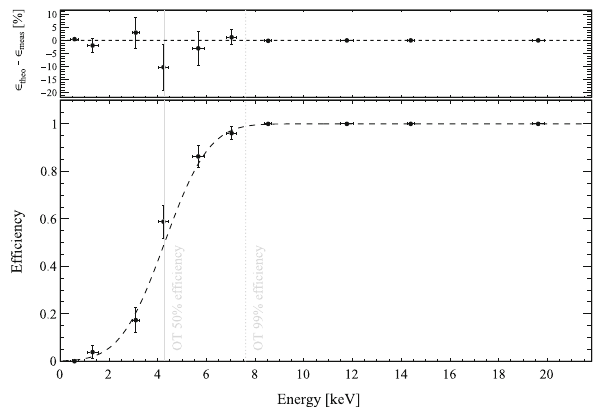
Fig. 1 (Bottom): An example of the trigger efficiency obtained from Eq. 1 as a function of energy (dashed line) and data obtained from low energy pulser measurements (circles). Energies where OT trigger efficiency reaches 50% ( θ ) and 99% ( E 99%trig ) are shown as vertical gray lines. (Top): The difference between the model and the data